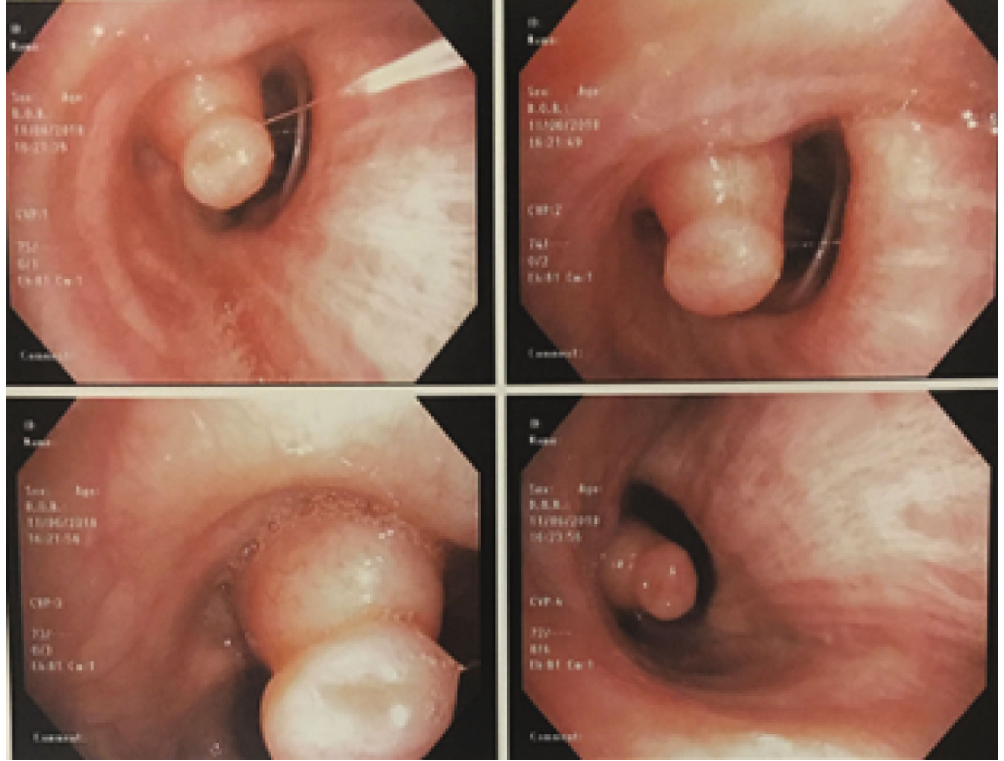
Figure 5: Flexible bronchoscopy: occlusion of the right middle lobe by a 1 × 1cm sessile lesion.